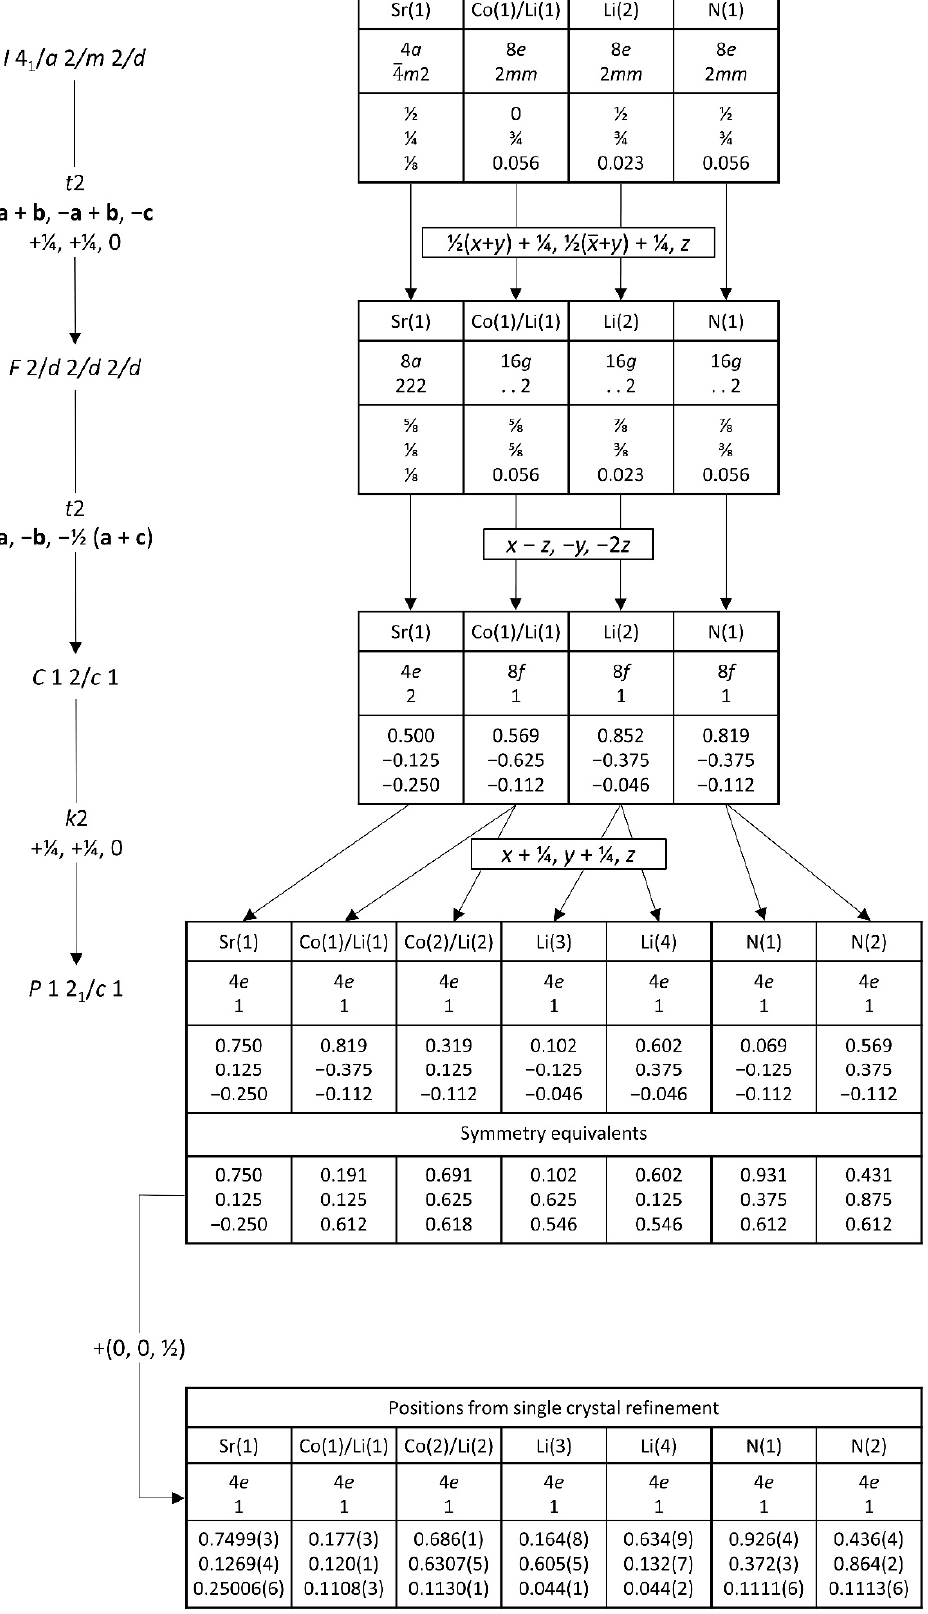
Figure 2. Bärnighausen symmetry tree diagram [16] describing the relation from I 4 1 / amd to P 2 1 / c for SrLi 2 {Li 0.65 Co 0.35 [Co 0.65 Li 0.35 N 2 ]}.